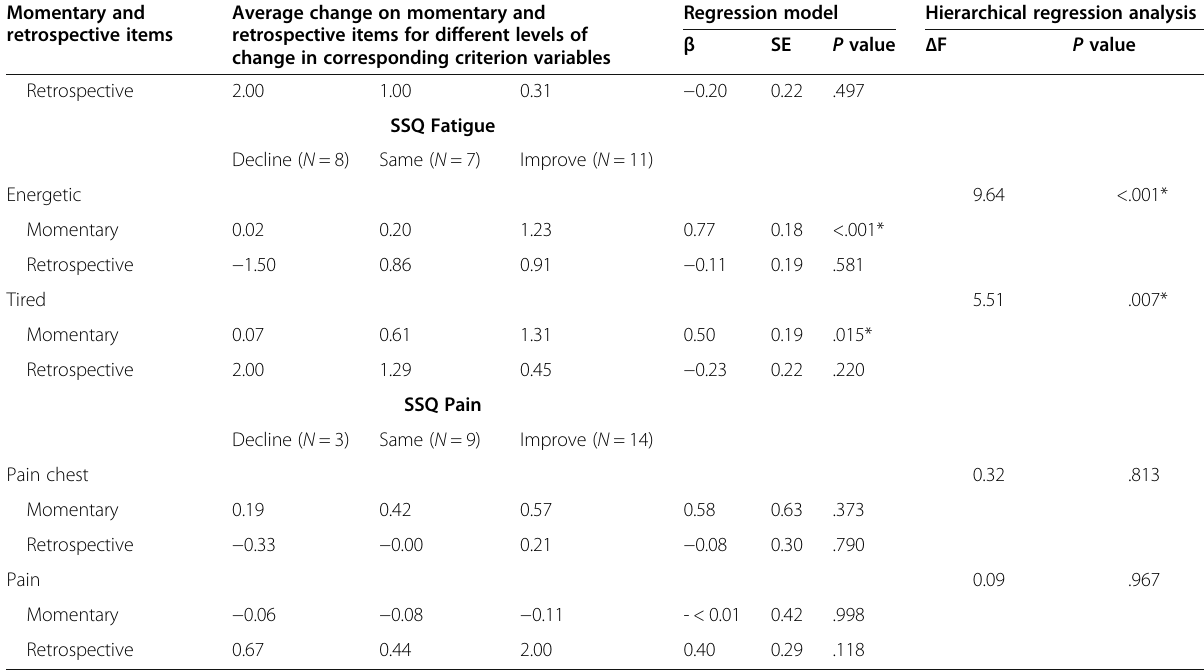
Regression model Hierarchical regression